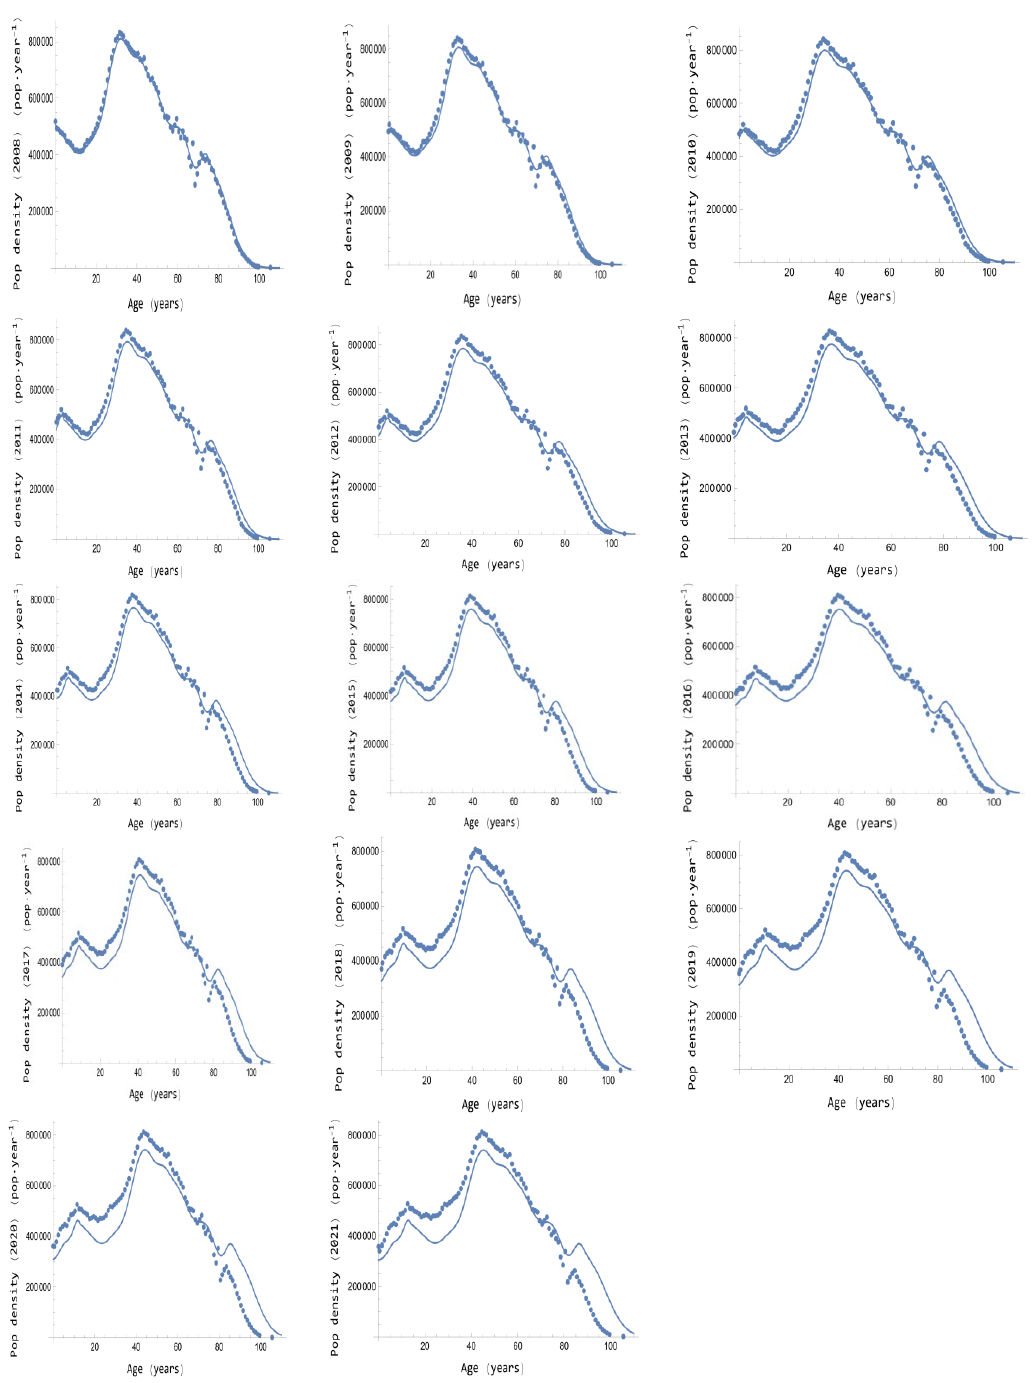
Figure 3. Population densities versus age in Spain for the 2008–2021 period. Experimental values (dots) and theoretical values (line). See the determination coefficients in Table 1.